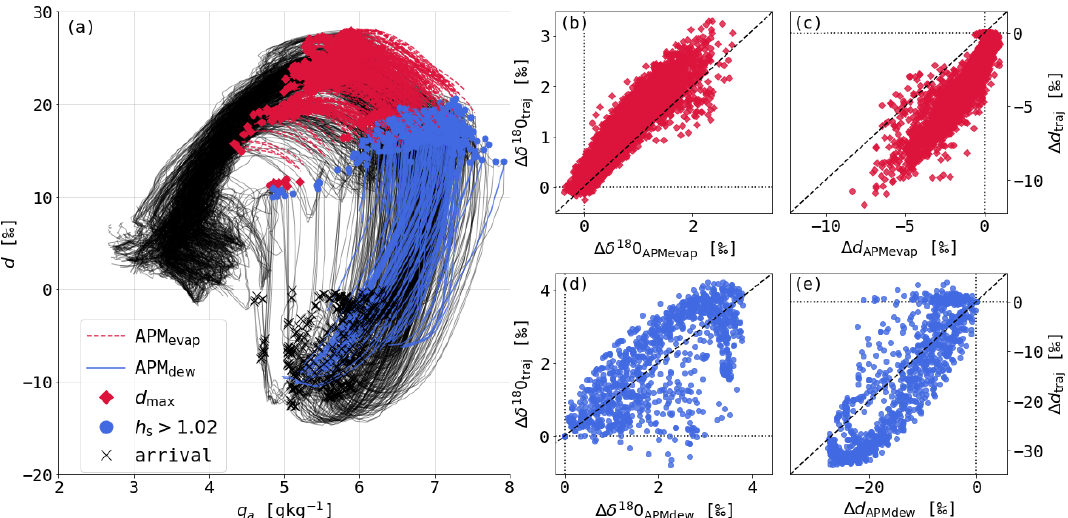
Figure 10. (a) Same as Fig. 9c but showing trajectories as black lines and the corresponding APM dew (blue solid lines) and APM evap (pink dashed lines) simulations using the SST and q a evolution of the COSMO iso trajectories. Markers denote specific events along the trajectories: the starting position of APM evap at highest d (pink diamond), the starting position of APM dew at the first instance when h > 1 . 02 along the trajectories (blue dot) and the arrival of the trajectories (black cross). Comparisons of changes in δ 18 O (b, d) and d (c, e) along COSMO iso trajectories (traj) and during the corresponding APM evap (b, c) and APM dew (d, e) simulations are shown. The changes in δ 18 O and d are shown relative to the initial composition of the APM simulations in 1-hourly